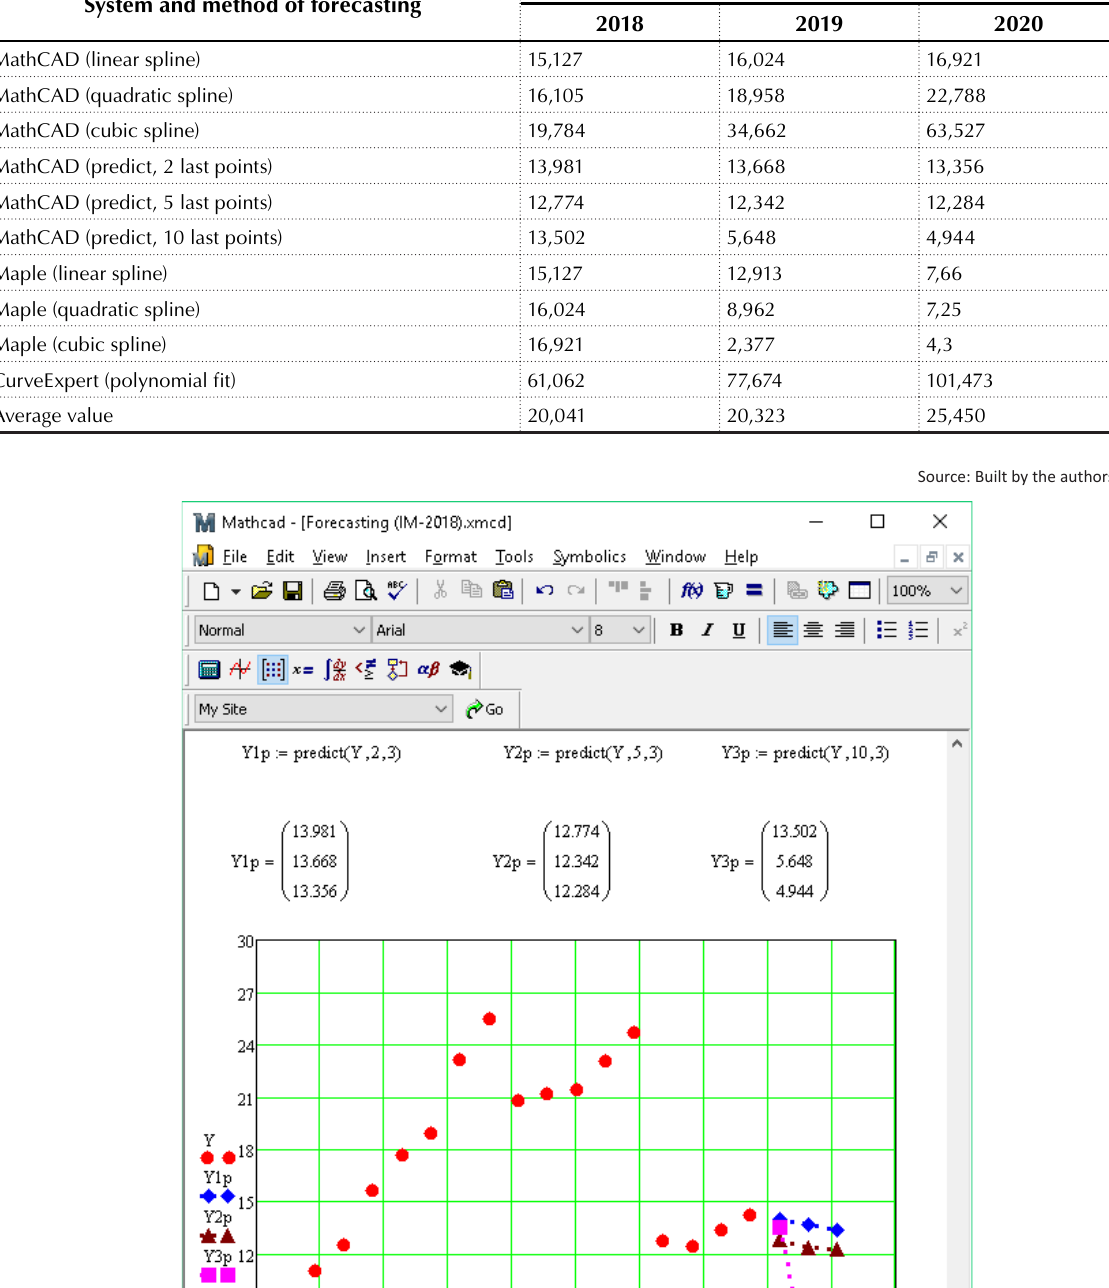
Table 5. Comparative analysis of forecasting